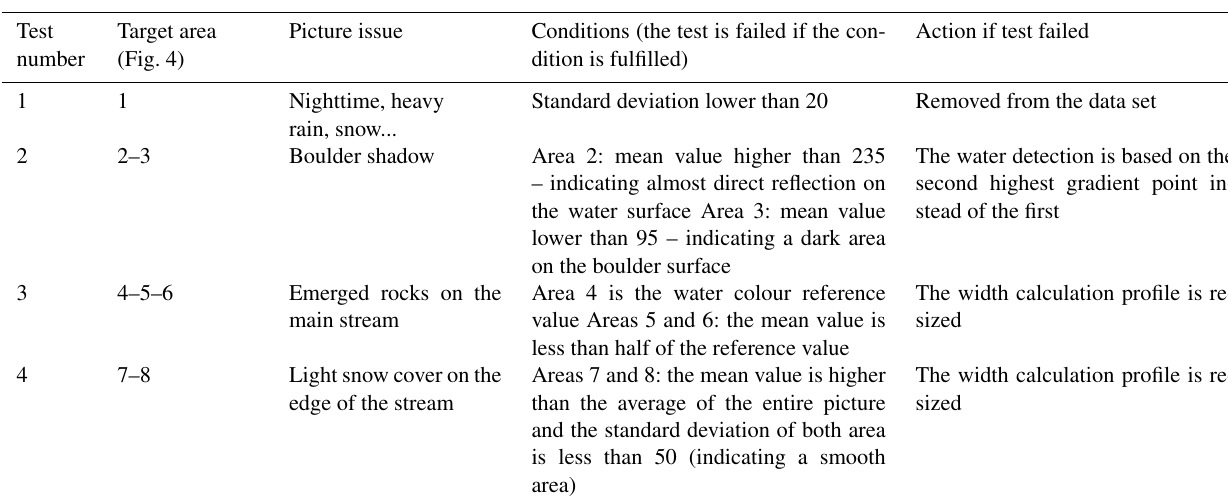
Table 1. The four different picture classification tests. The standard deviation ranges from 0 to 255. Thresholds are set using both particular and normal condition pictures. The different areas have been chosen to avoid parameter distribution overlap between normal and particular conditions (see the